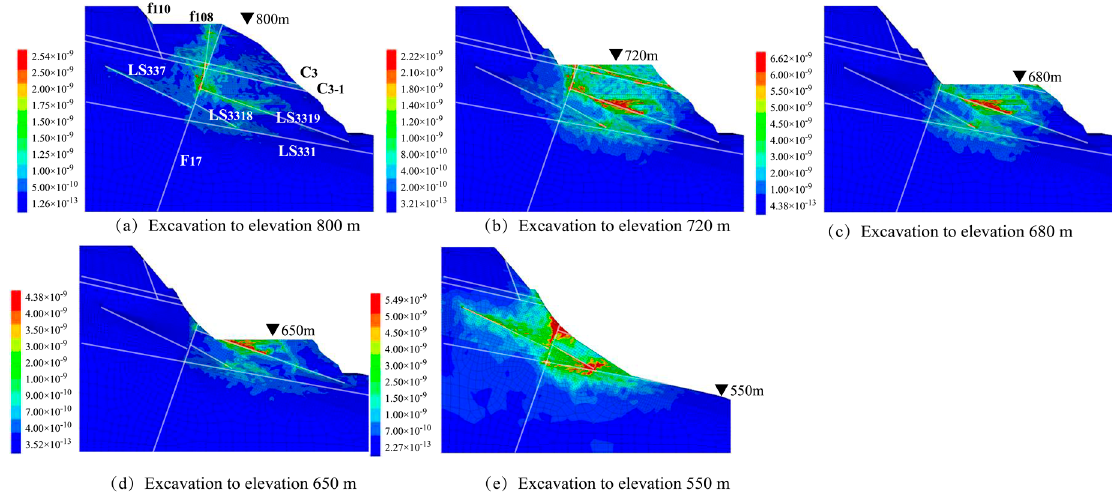
Figure 14. Shear rate of the rock slope considering the damaging effect of the MS event during excavation processes. Excavation to elevation ( a ) 800 m, ( b ) 720 m, ( c ) 680 m, ( d ) 650 m, and ( e ) 550 m.